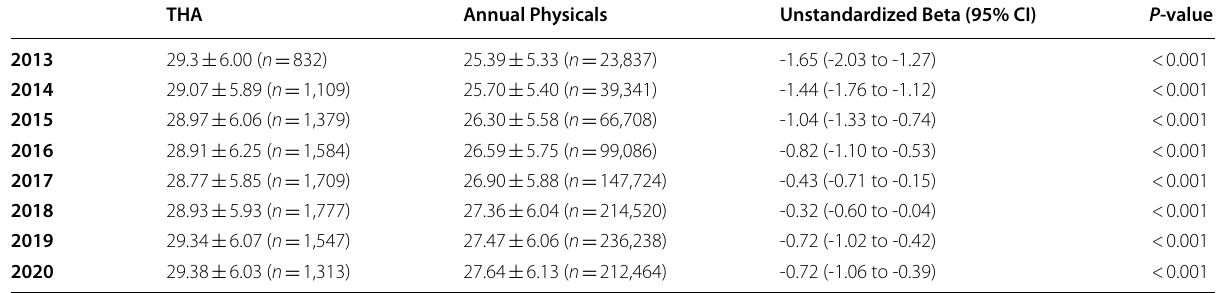
Table 2 Trends of BMI 2013–2020 (BMI; kg/m 2 )